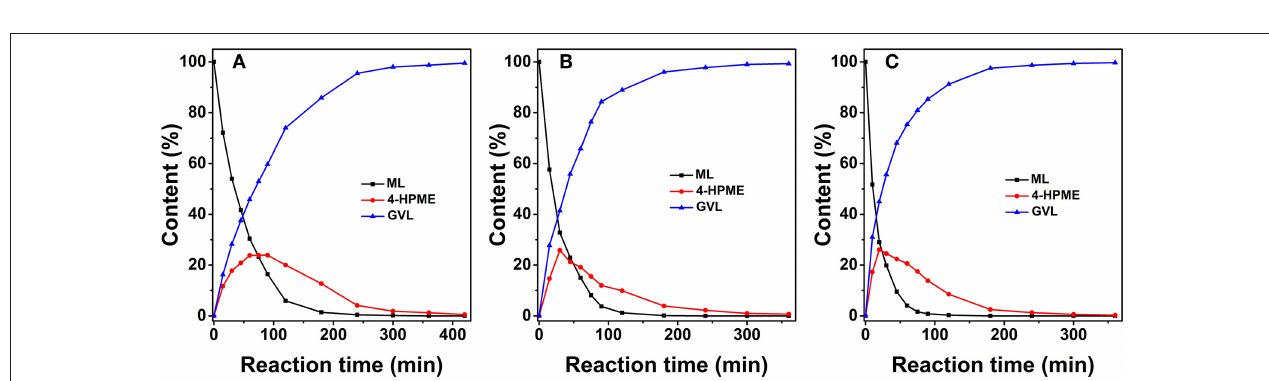
FIGURE 6 | Concentration evolution profiles of ML, MHV, and GVL vs. time for 2.0% Ru/11.7% SiW@UiO − 66 at 60 ◦ C (A) , 80 ◦ C (B) , and 100 ◦ C (C) . Reaction conditions: 0.257g of ML, 50mg of catalyst, 15mL of H 2 O, and a H 2 pressure of 0.5 MPa.